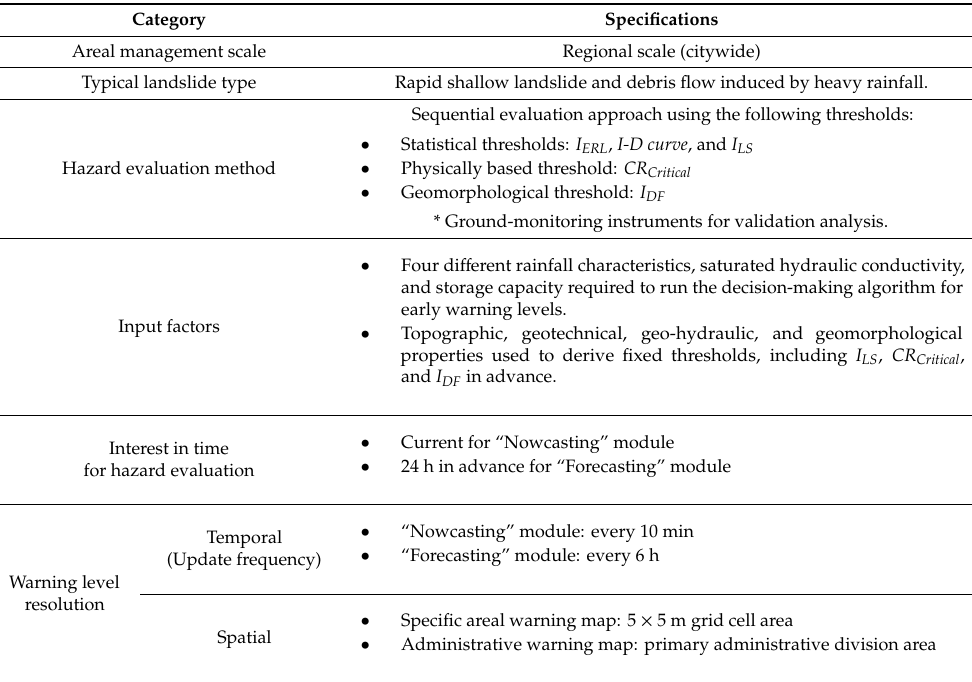
Figure 2. Structure of the landslide early warning system for Busan based on the sequential evaluation method. Table 1. Specifications of the landslide early warning system for Busan based on the sequential evaluation method